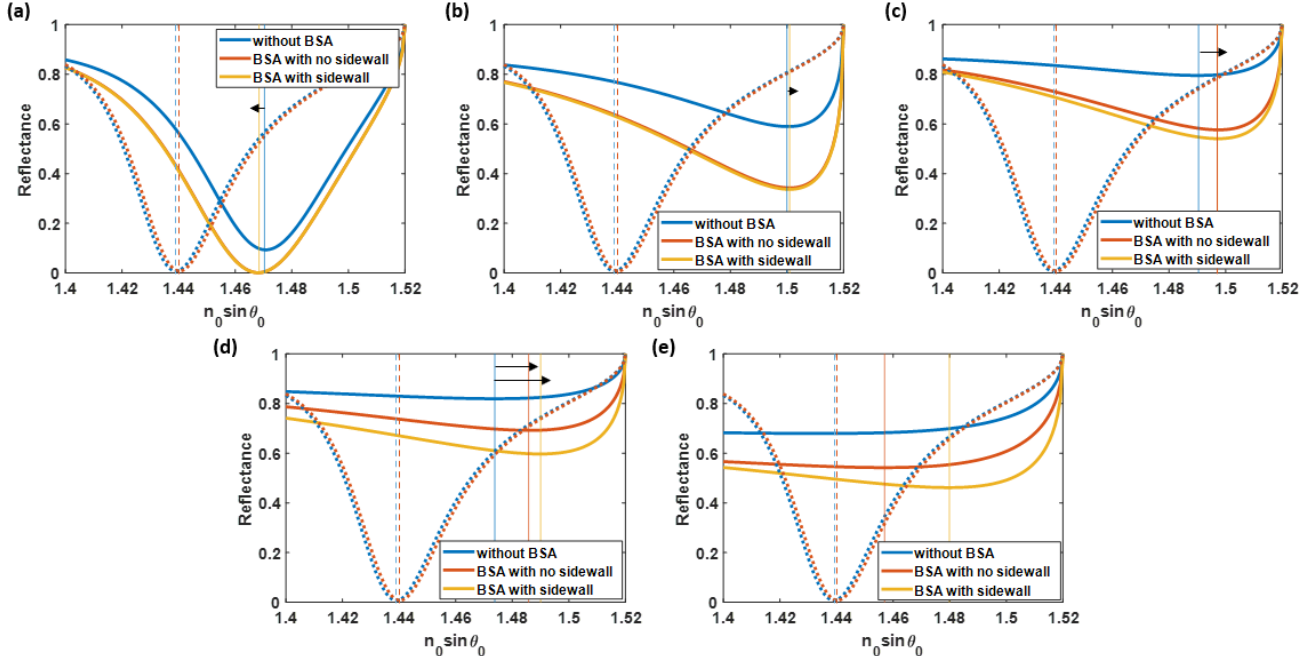
Figure 9. ( a ) the reflectance spectra with a negative sensitivity at the operating point ‘a’, ( b ) degraded-sensitivity reflectance curves at the operating point ‘ b ’ , ( c ) enhanced-sensitivity reflectance spectra at the operating point ‘c’ , ( d ) highly enhanced-sensitivity reflectance spectra at the operating point ‘ d ’ , and ( e ) the reflectance curves at the highly rough surface where the sensitivity cannot be computed at the operating point ‘ e ’ . Note that the dotted curves indicate the plasmonic angles of the ideal uniform gold cases and the black arrows indicate the plasmonic angle shift direction.